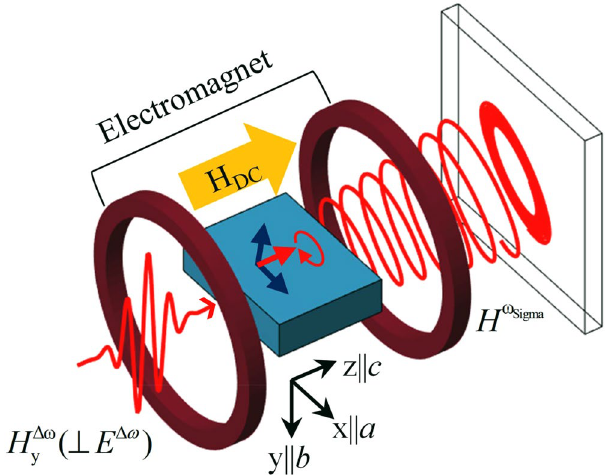
Figure 4. Schematic diagram for THz emission in YFeO 3 after excitation by a vertically polarized magnetic pulse of light, ∆ω H . When ∆ω H is incident on the sample, the magnetizations are tilted away from their y y equilibrium position; subsequently, they return to the original position, precessing at a frequency of 0.3 THz via the internal magnetic field, and emitting a free-induction decay signal as the elliptically polarized light. Here, the DC magnetic field, h z,DC , from the Helmholtz-type coils is used for magnetization saturation in the direction of the - z -axis or the crystalline c -axis. We set the crystalline axes, a , b , and c to correspond to the Cartesian axes, x , y , and z .